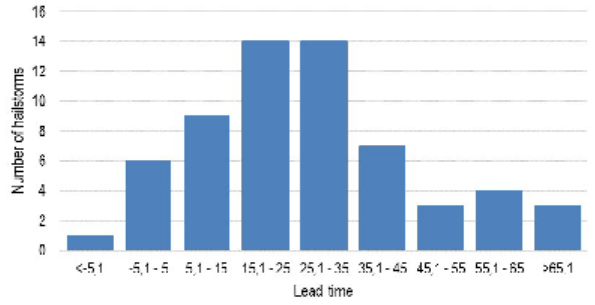
Fig. 10. The number of hailstorms with the given lead